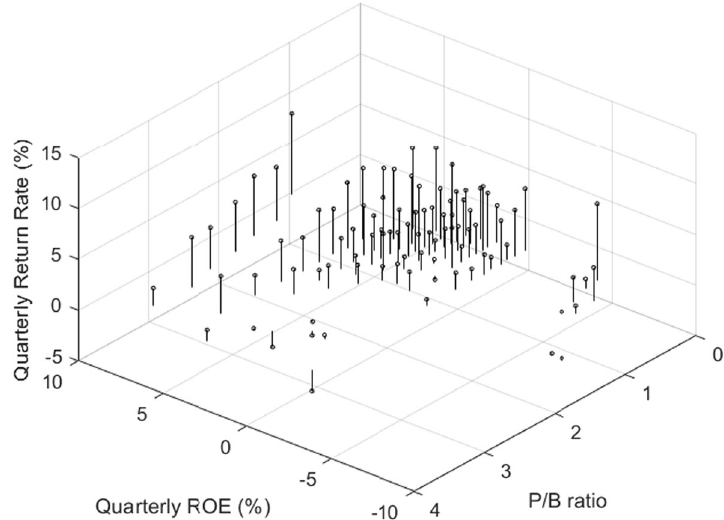
Fig. 35 3D pin chart of ROE (X), P/B (Y) in the t quarter, and the return rate in the t portfolio are formed (Z)